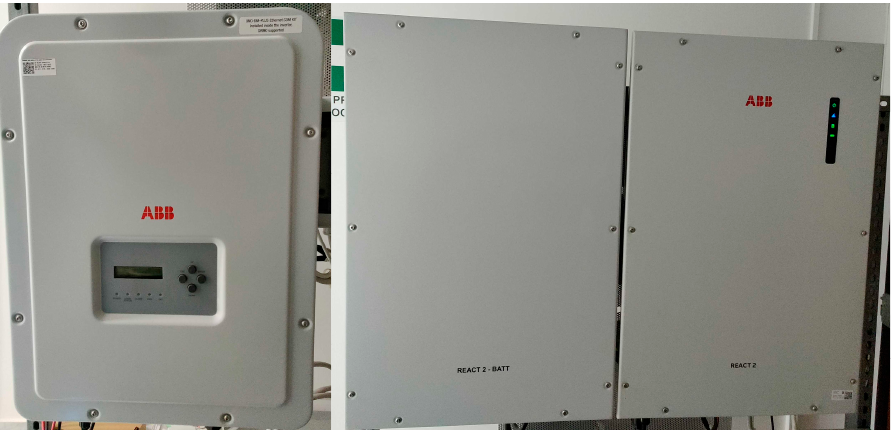
Figure 11. The 3 kW–12 kWh ba tt ery energy storage system, model React2, produced by ABB.